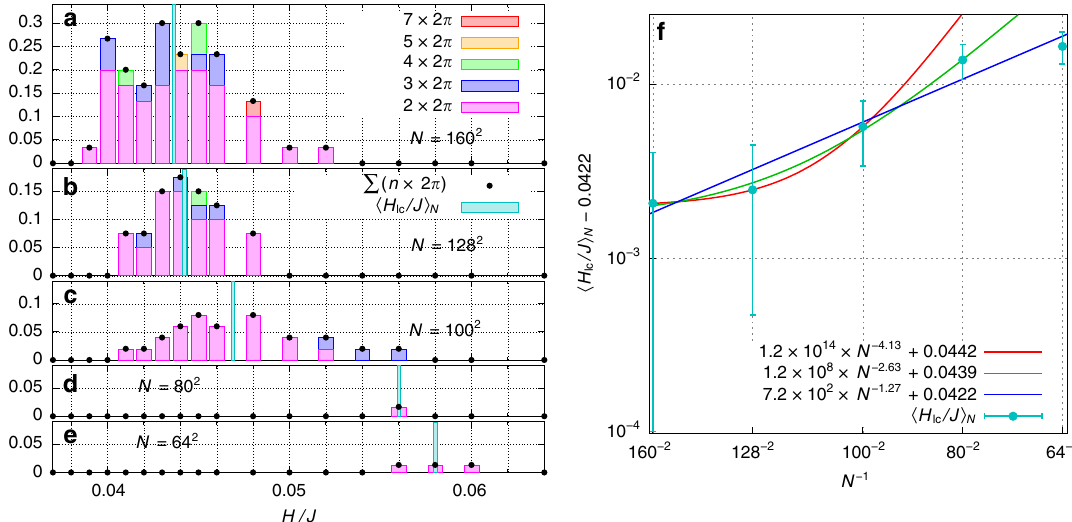
Fig. 5 Multiperiod limit cycles at zero temperature. a – e show what fraction of limit cycles that exhibit multiperiodicity as a function of driving fi eld strength H at R x = 0.5 J . The smallest system size we simulated, N = 64 × 64, is shown on the bottom left in e . System size increases from bottom to top in the left panels, up to system size N = 160 × 160. In the bar graphs, period-2 limit cycles are shaded pink; period-3 limit cycles are purple; period-4 limit cycles are green; the period-5 limit cycle is orange; and the period-7 limit cycle is red. We did not observe any period-6 limit cycles. Black dots represent the net contribution from all multiperiod limit cycles at each fi eld. In each bar graph, the vertical blue line is the mean of the distribution function, < H lc > in units of J . f From the results of a – e , we plot h H lc i N vs. the inverse of system size N on a log – log scale. In f , the error bars are standard deviations over the histograms in a – c , e , respectively. For the fourth point (arising from d ), we estimate the error to be the average of that in the third and fi fth points. A power law fi t of h H lc i N for the three largest system sizes is given by the red curve; the fi t for the four largest system sizes is given by the green curve; and the fi t for all calculated system sizes is given by the dark blue curve. The y -intercept is consistent among all of these fi ts, yielding an average value of h H i ¼ ð 0 : 0434 ± 0 : 0020 Þ J . N !1 lc Table 1 Critical fi eld